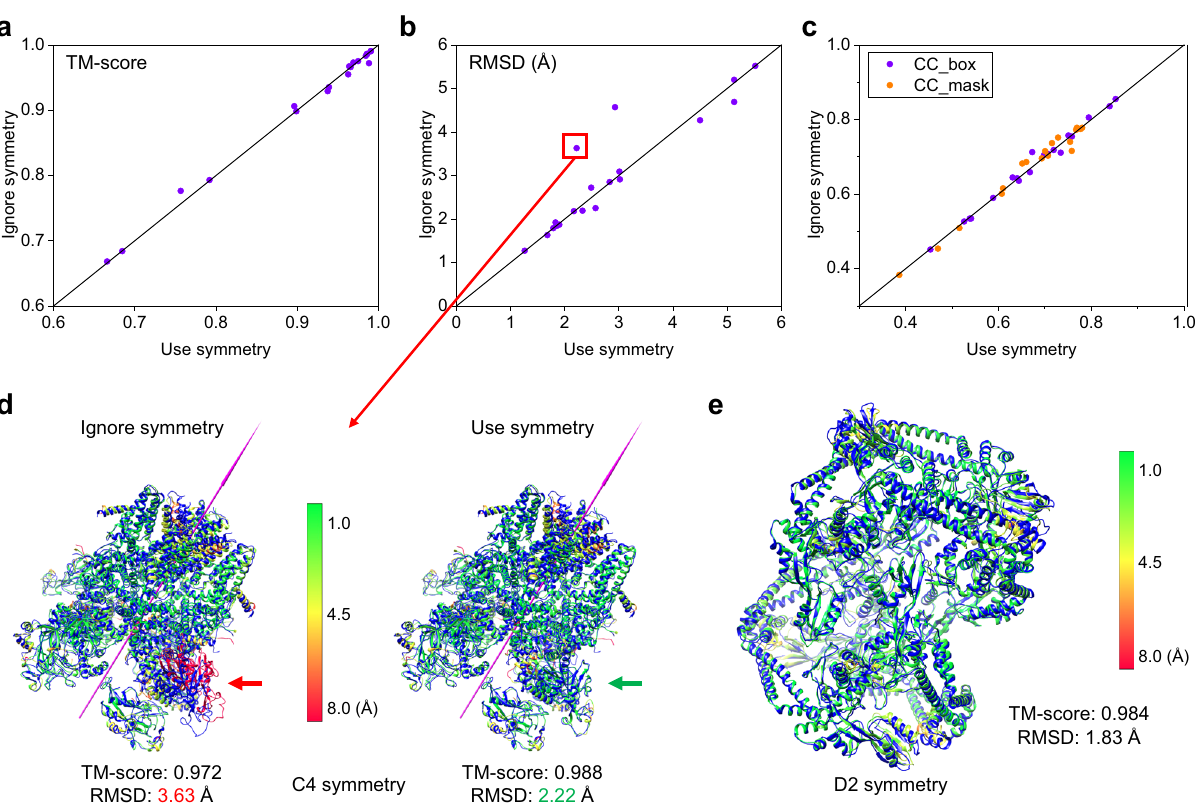
Fig. 9 Comparison of the EMBuild models with and without using symmetry information, on the test set of 19 single-particle EM maps with C or D symmetry. a – c Comparison of TM-score ( a ), RMSD ( b ), and CC values ( c ) between the EMBuild models built with and without symmetry information on each test case. Highlighted in the red box of b is the case that has a signi fi cantly lower RMSD value after using symmetry information. d The example of EMD-20479 highlighted in b with C4 symmetry. The deposited structures are colored in blue, and the EMBuild models built with symmetry information (left) and without symmetry information (right) are colored by C α displacements to the deposited PDB structure. Arrows colored in magenta indicate the axis of symmetry. Indicated by red and green arrows is a part of structure that is improved after using symmetry information. e An example with D2 symmetry (EMD-9317). The deposited PDB structure is colored in blue, and the EMBuild model with symmetry information is colored by C α displacements to the deposited PDB structure. Source data are provided in the Source Data fi